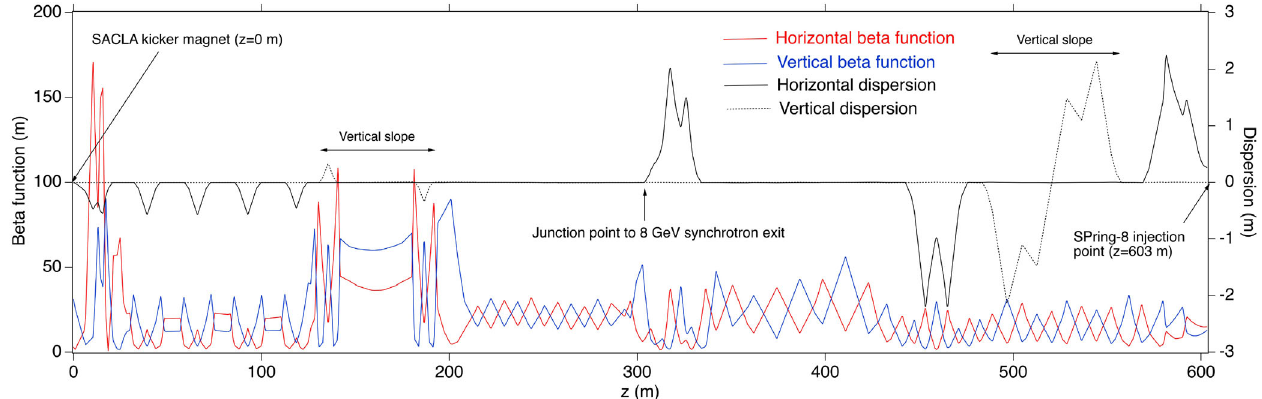
FIG. 3. Beta functions and dispersion functions of XSBT from the SACLA kicker magnet to the beam injection point of the SPring-8 storage ring. Horizontal and vertical beta functions are shown in red and blue solid lines, and horizontal and vertical dispersion functions are shown in black solid and dotted lines.